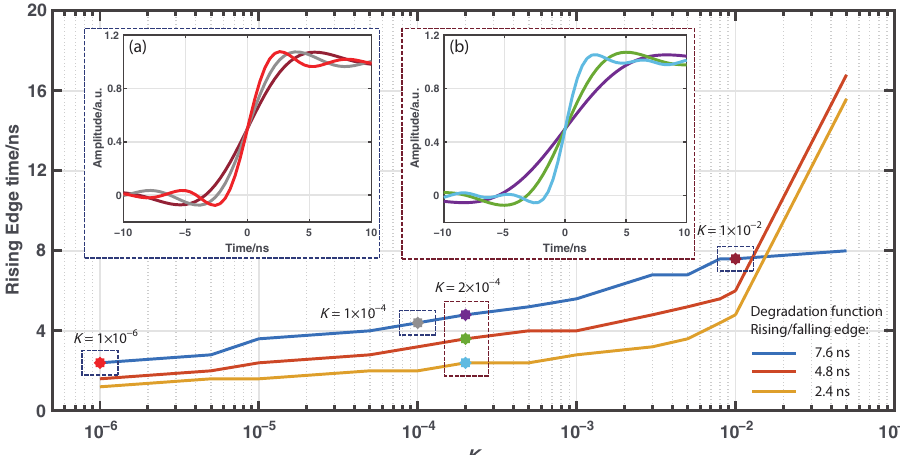
Figure 3. Evolution of the 10/90% rising edge time of simulated deconvoluted Raman signals over parameter K for ψ † ( t ) with FWHM of 20 ns and rising/falling edges of 7.6, 4.8, and 2.4 ns. Inset: ( a ) Rising edges of the simulated Raman signals for different K values and ψ † ( t ) with FWHM of 20 ns and rising/falling edge of 7.6 ns. ( b ) Rising edges of the simulated Raman signals for the same hl K = 2 × 10 − 4 and ψ † ( t ) with FWHM of 20 ns and rising/falling edges of 7.6, 4.8, and 2.4